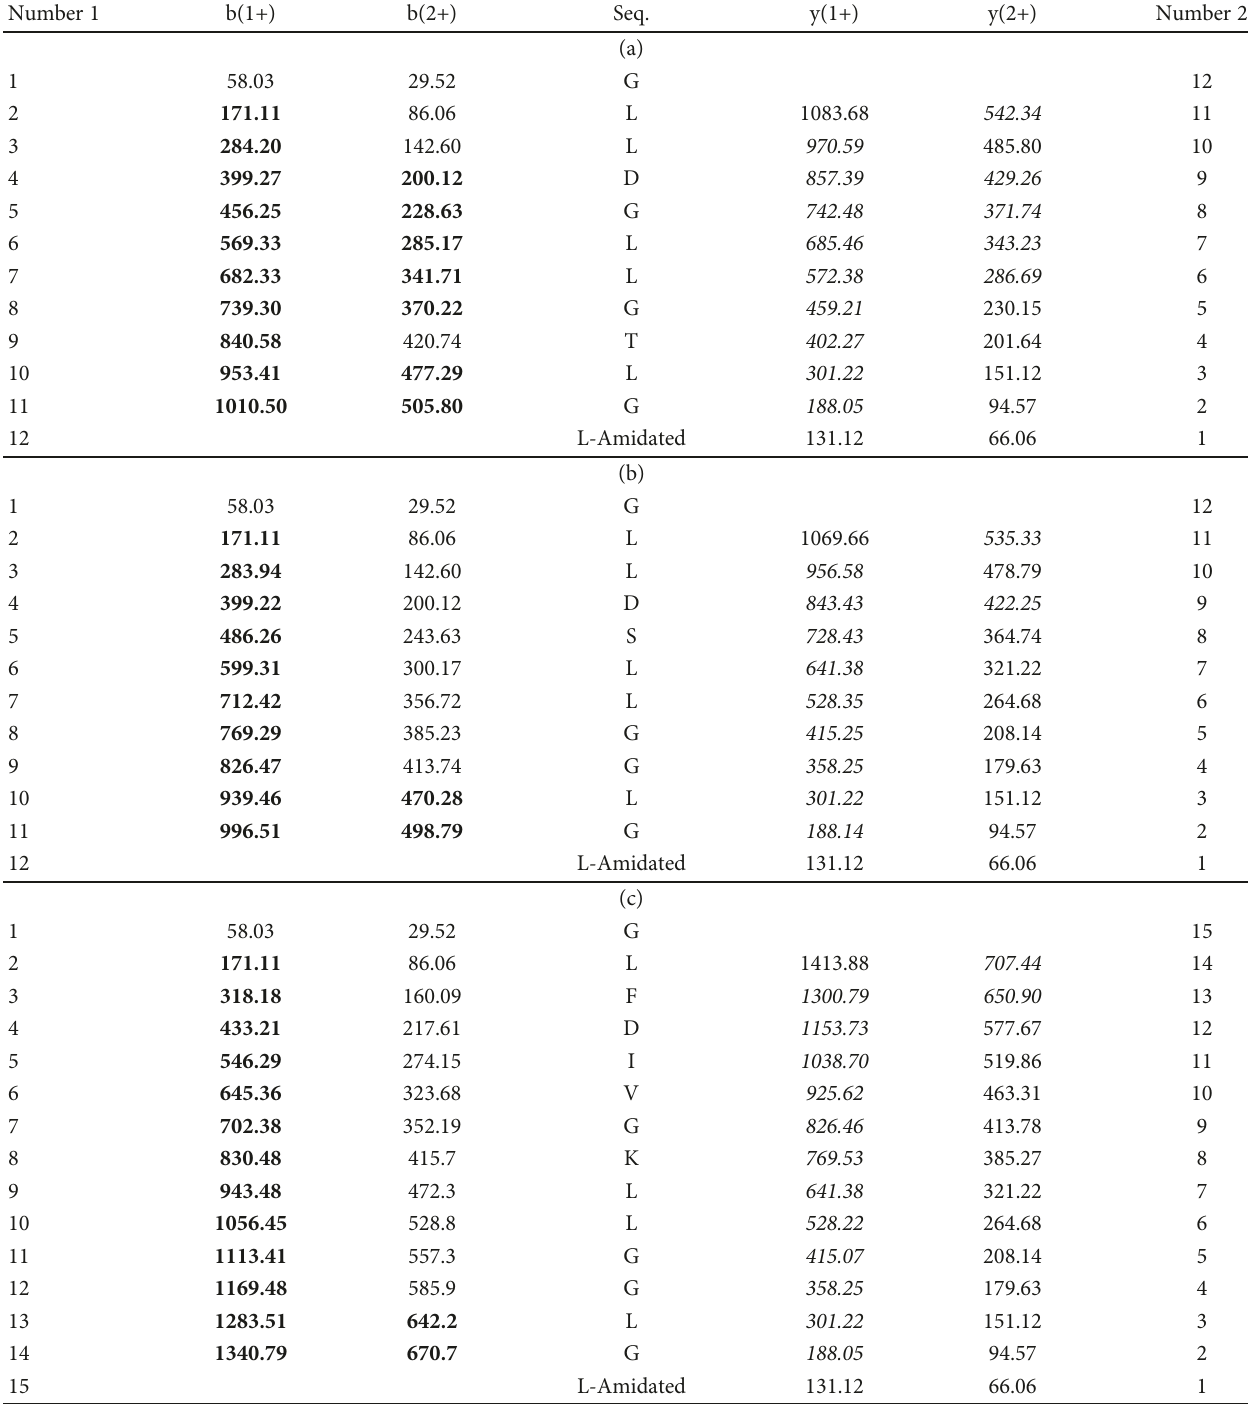
Table 1: Predicted singly and doubly charged b ions and y ions arising from MS/MS fragmentation of (a) Caeridin-1, (b) S5-Caeridin-1, and (c) Caeridin-a1. Actual fragment ions observed following MS/MS fragmentation are indicated in bold and